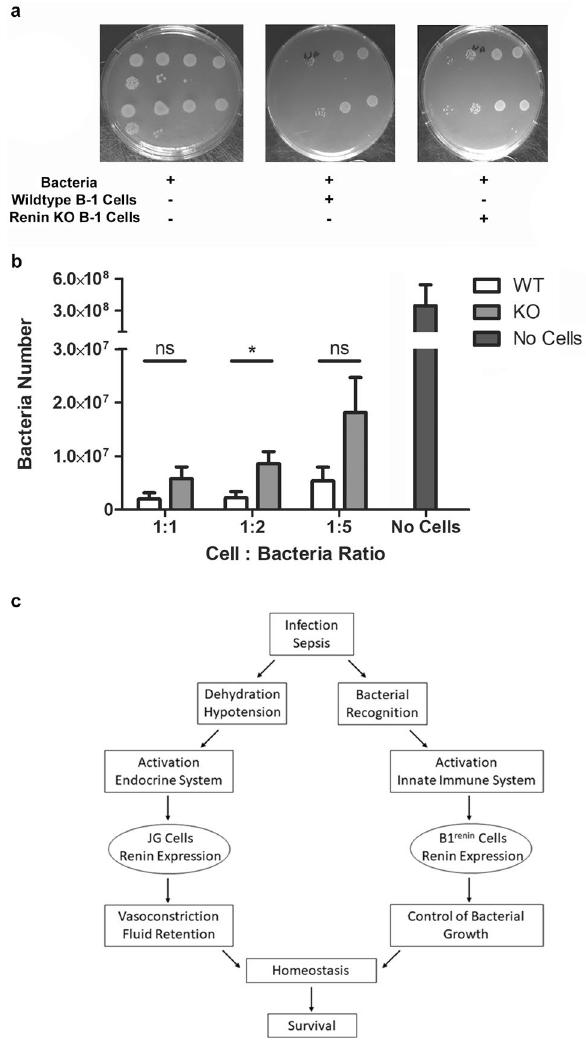
Figure 4. Peritoneal cells from renin KO mice have decreased ability to inhibit bacterial growth in vitro. ( a ) Peritoneal B-1 lymphocytes were obtained from wildtype and renin-KO mice. These cells were co-cultured with Salmonella typhimurium bacteria for 2 h. A third group included Salmonella typhimurium bacteria alone. Cells were removed after 2 h, and the bacteria were grown in agar for 24 h. Bacteria numbers were then calculated. ( b ) These experiments were repeated at cell:bacteria ratios of 1:1, 1:2, and 1:5. Each experiment was performed 5 times, and the results were grouped together. Statistical significance was determined using the Mann–Whitney test as values represented paired observations (WT vs KO 1:2 cell:bacteria ratio, P = 0.0362). ( c ) Schematic as to how the endocrine renin-angiotensin system and the innate immune system coordinate efforts in response to threats to